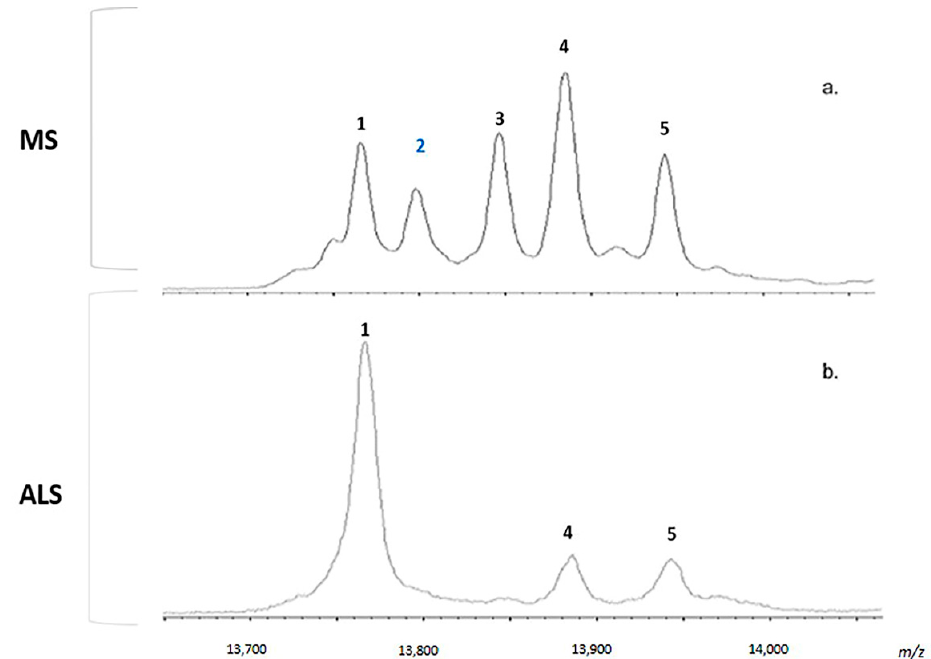
Figure 5. CSF average MALDI-TOF spectra zoomed in the 13 kDa region related to cerebral transthyretin (TTR). Panel ( a ) shows multiple sclerosis (MS) average CSF spectrum, while panel ( b ) shows average spectrum of CSFs with Amyotrophic Lateral Sclerosis (ALS). TTR Free monomeric specie ( m/z = 13,761 Da, peak 1) and canonical mixed disulfides of monomeric TTR with free thiols with cysteine and cystein-glycine at m/z = 13,880 Da (peak 4) and 13,937 Da (peak 5), respectively, are shown for both spectra. MS spectrum also shows mixed disulfides with mass shift of +32 Da (peak 2) and +80 Da (peak 3), with respect to free monomeric specie ( m/z = 13,761 Da, peak 1), referable to S-sulfhydration, highlighted in blue, (Cys-S-SH) and S-sulfonation (Cys-S-SO3H) of the Cys10 of the protein.